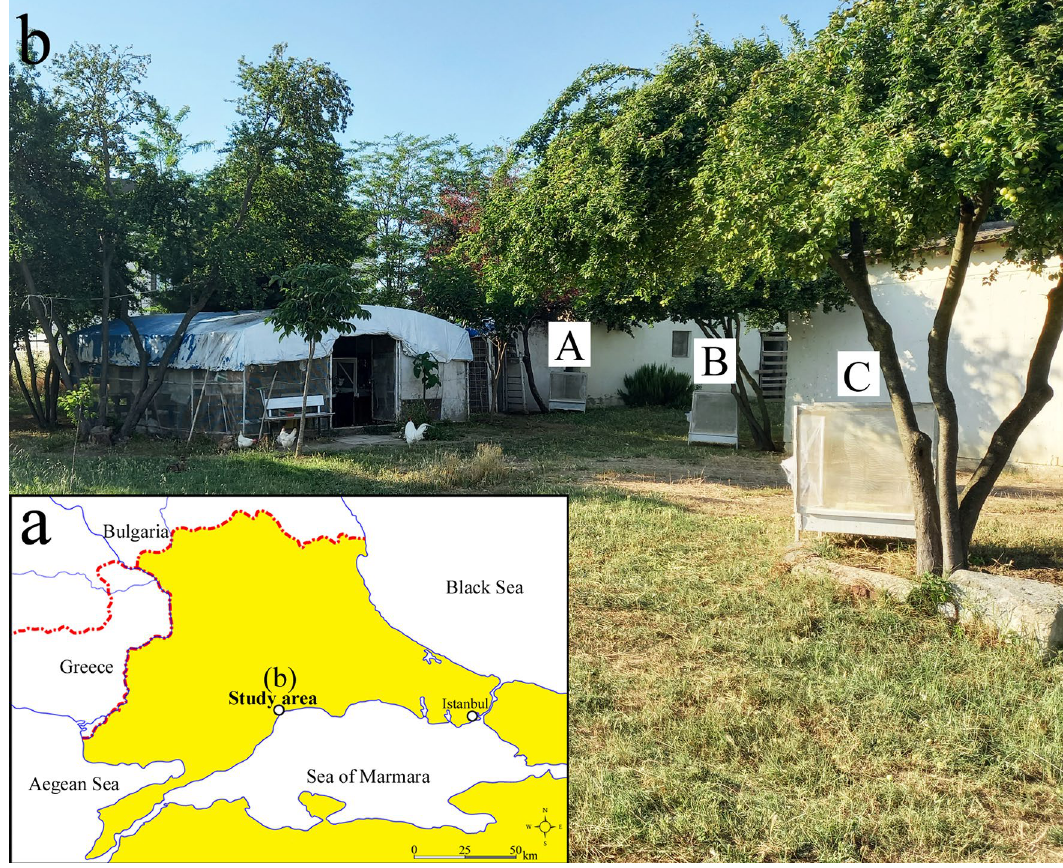
Figure 1. Geographic location ( a ) (retrieved from https:// www. simpl emappr. net; accessed June 19, 2022) of the study area ( b ) and placement of the cages used in the trials (A, B, and